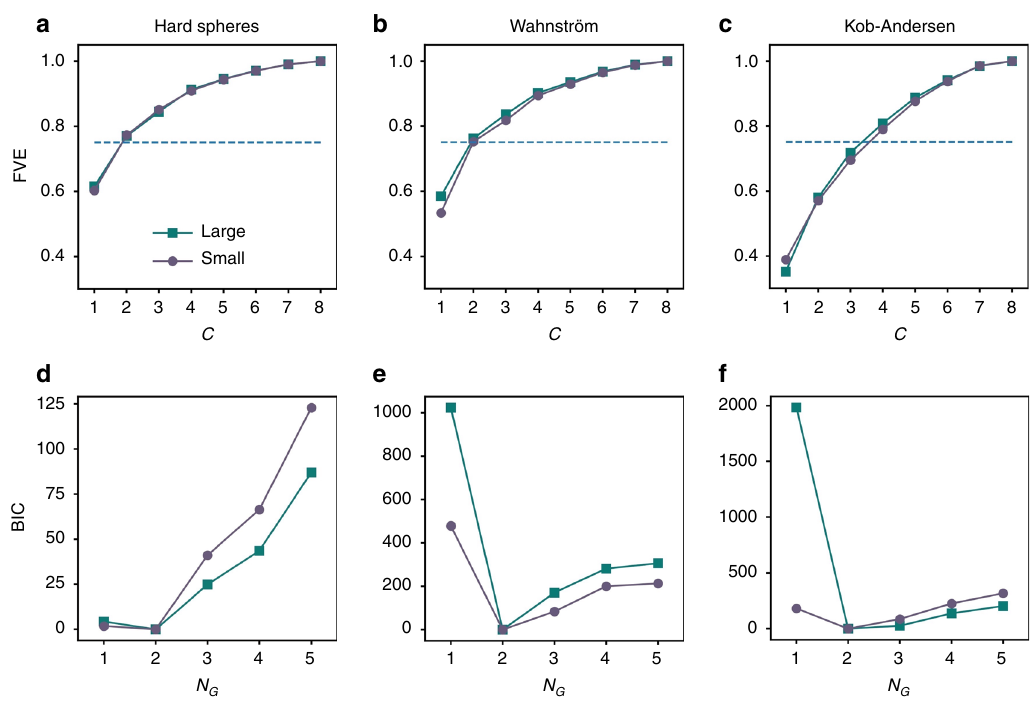
Fig. 2 Determining UML parameters. a – c Fraction of variance explained (FVE) as a function of the dimension of the bottleneck, c , for large and small particles in the three glass formers. The dashed blue line corresponds to a threshold of FVE = 0.75. d – f Bayesian information criterion (BIC) as a function of the number of Gaussian components, N G , for large and small particles in the three systems. Note that for illustration purposes the BIC has been shifted to have a minimum value of BIC = 0. The three systems are, from left to right: hard spheres with packing fraction η = 0.58, size ratio q = 0.85, and composition x L = 0.3, Wahnström at density ρ * = 0.81 and temperature T * = 0.7, and Kob – Andersen at density ρ * = 1.2 and temperature T * =